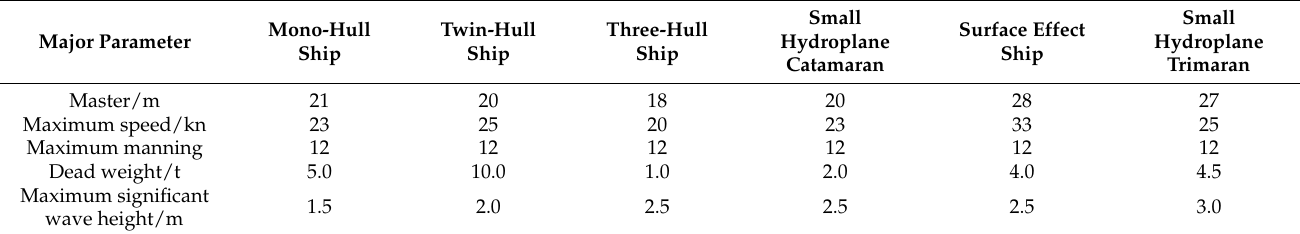
Table 1. Typical parameters of different types of ship